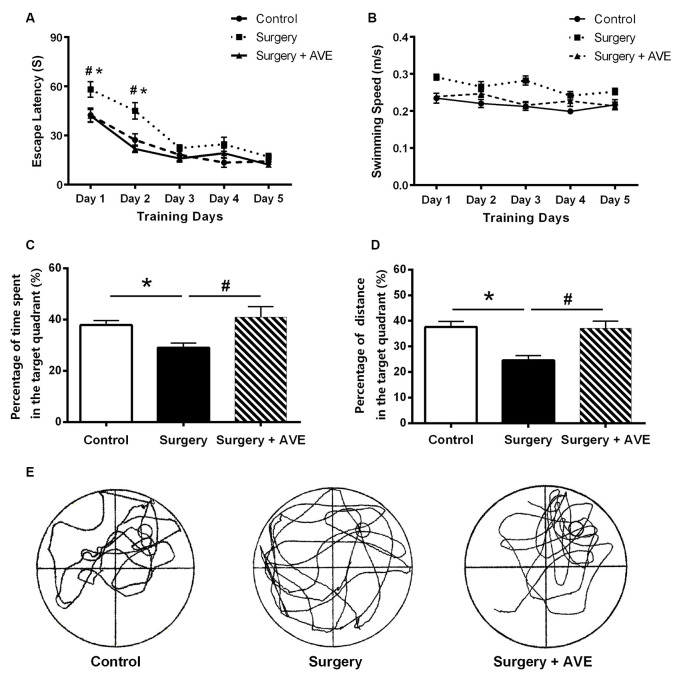
AVE 0991 treatment alleviated the hippocampal-dependent spatial memory impairment in aged rats after surgery. (A) Escape latency for rats to reach the platform in the navigation trials, which measures the ability of the animals to acquire spatial information. (B) Swimming speeds of the aged rats. (C) Percentage of exploration time spent within the target quadrant during probe trials. (D) Percentage of exploration distance within the target quadrant during probe trials. (E) A representative exploration trajectory. Values are the mean ± SEM (n = 10 per group). *p < 0.05, vs. control group; #p > 0.05, vs. surgery group.